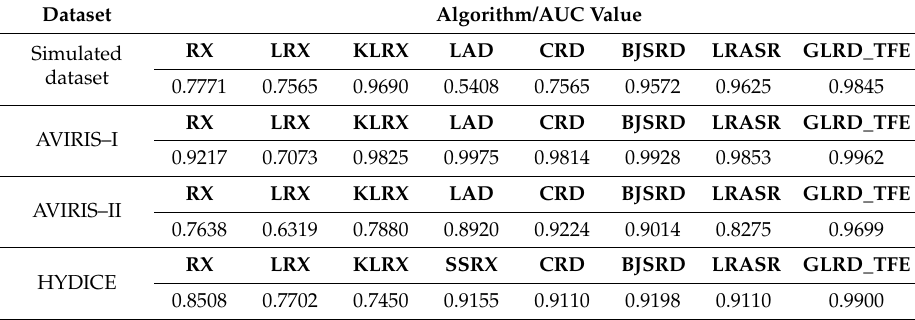
Table 1. AUC values of detection results by all comparison methods in four